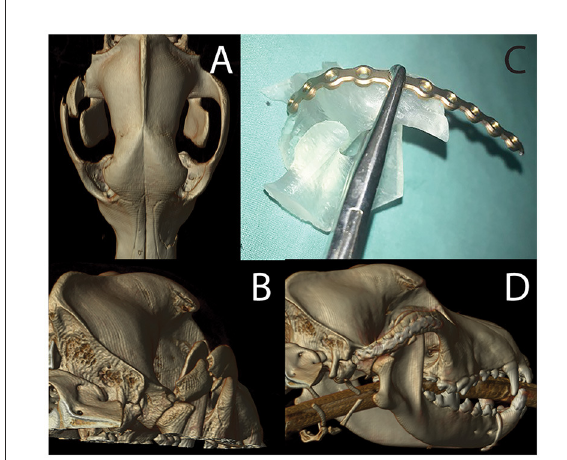
FIGURE11 Volumetric rendering of dorsal (A) and caudal (B) views revealing the fracture segment in case 2. The photograph of mirror image 3D printed temporomandibular apparatus (C) was used for implant recontouring. A volumetric rendering of the post-operative CT study reveals excellent implant placement and good fracture alignment (D) .